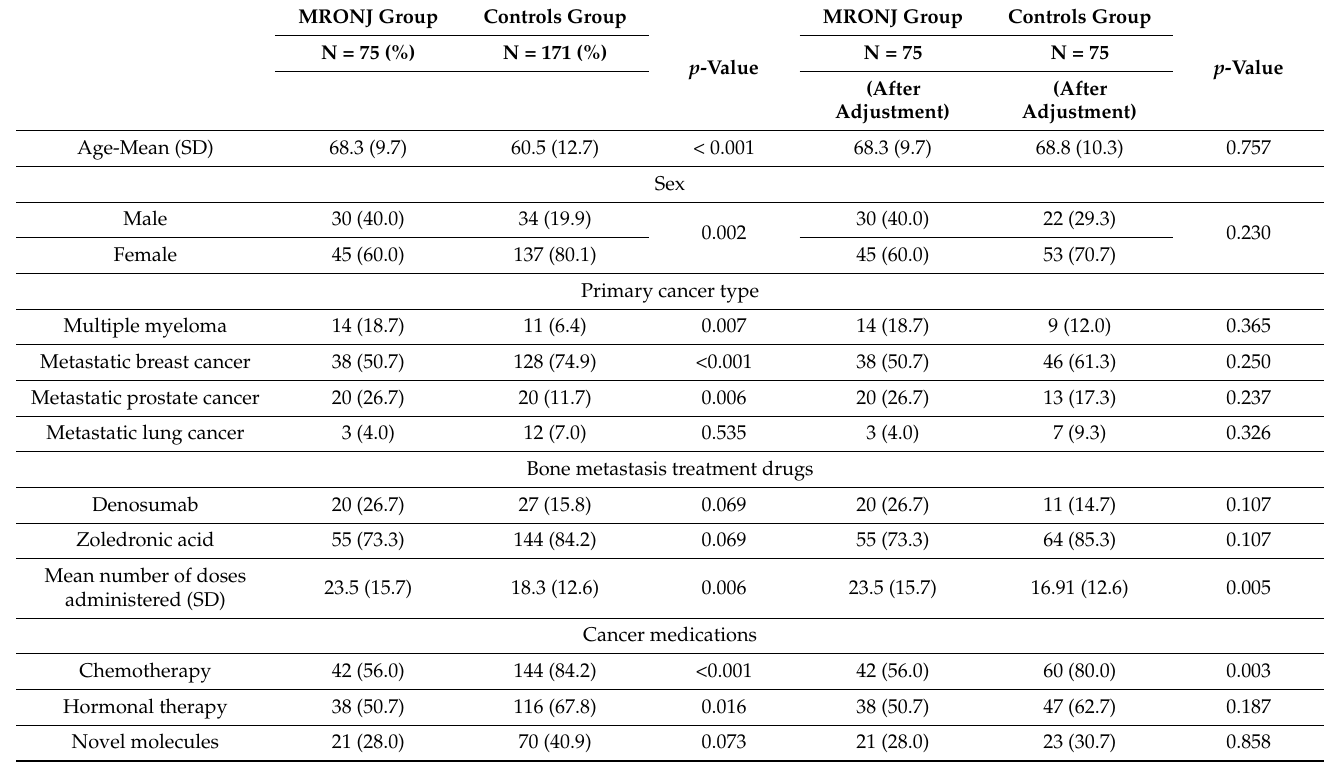
Table 1. Characterization of cases and controls before and after